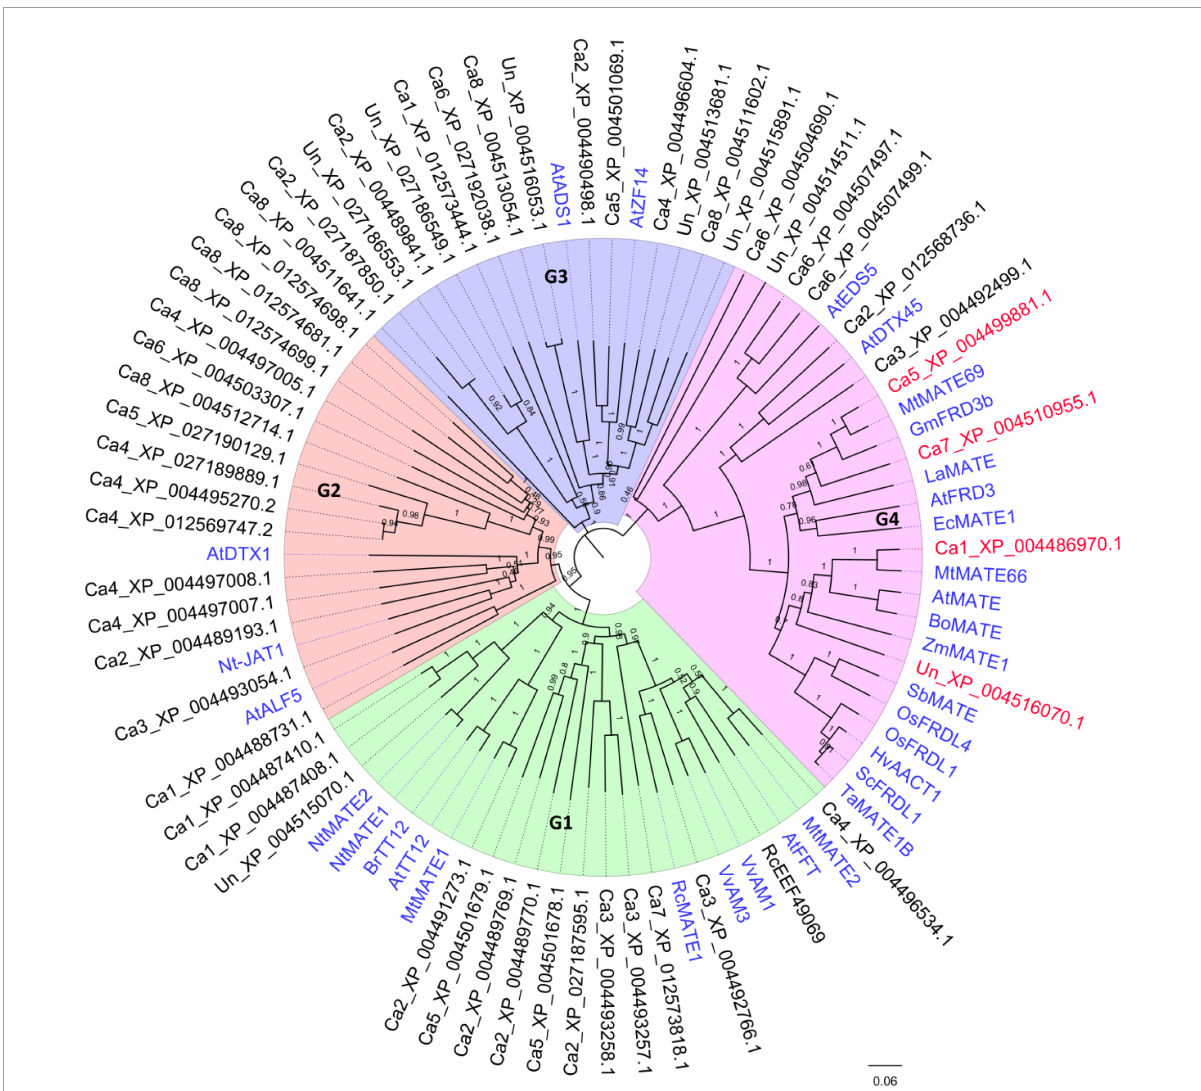
FIGURE2 Phylogeny of MATE homologous genes in chickpea and other plants. The NJ phylogeny includes the chickpea protein sequences containing the MatE (PF01540) domain (retrieved from NCBI database BioProject: PRJNA190909). Previously characterized homologous MATE proteins were included as references (highlighted in blue). The target MATE genes CaMATE1 and CaMATE2 were in red. The Bootstrap support (1000 times iterations) was indicated above each